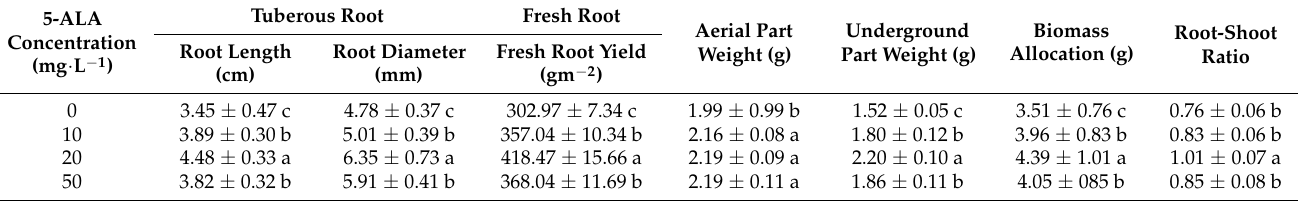
Table 1. Effects of different concentrations of 5-ALA on growth of P. heterophylla tuberous